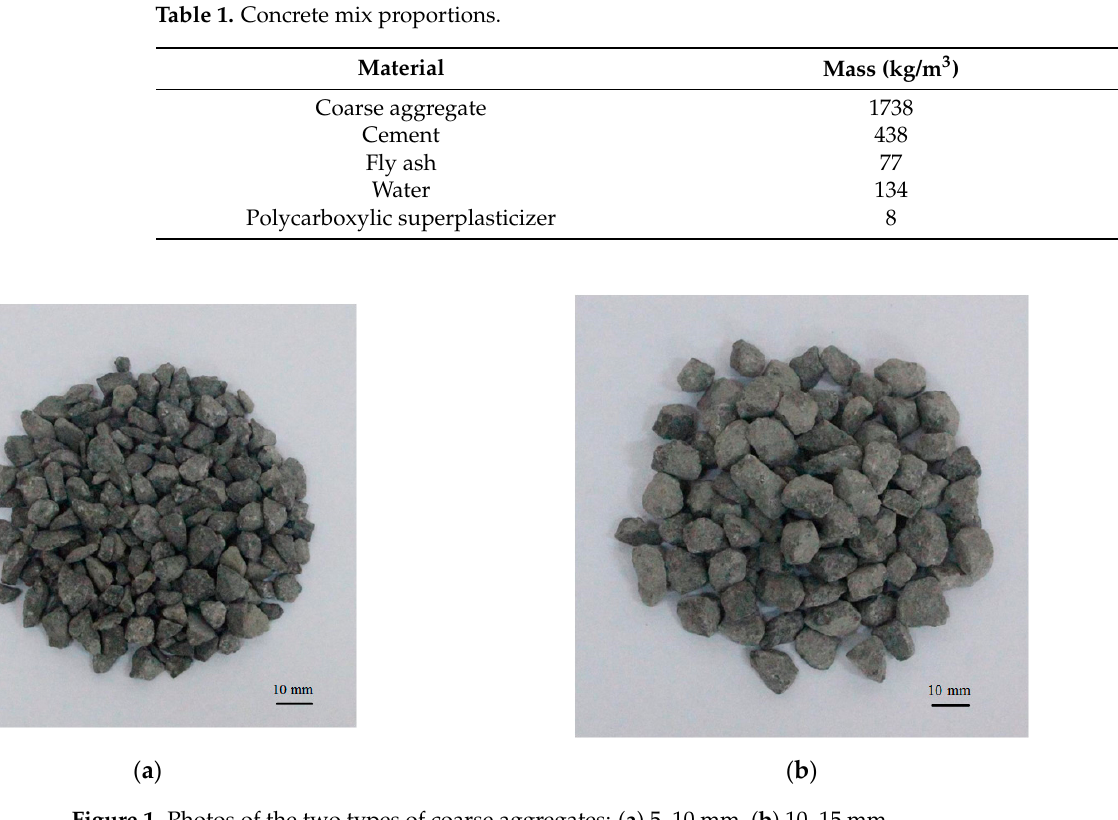
Figure 1. Photos of the two types of coarse aggregates: ( a ) 5–10 mm, ( b ) 10–15 mm. Polypropylene biaxial geogrid with 40 mm × 40 mm apertures and a tensile strength of 21 kN/m was used as reinforcement in pervious concrete as shown in Figure